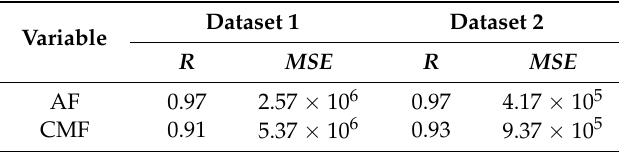
Table 3. Correlation coefficient ( R ) and mean squared error ( MSE ) for the prediction of the AF and CMF for both Dataset 1 and Dataset